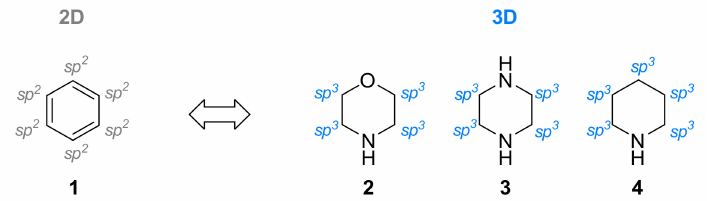
Figure 1. The most abundant 2D and 3D rings in APIs.